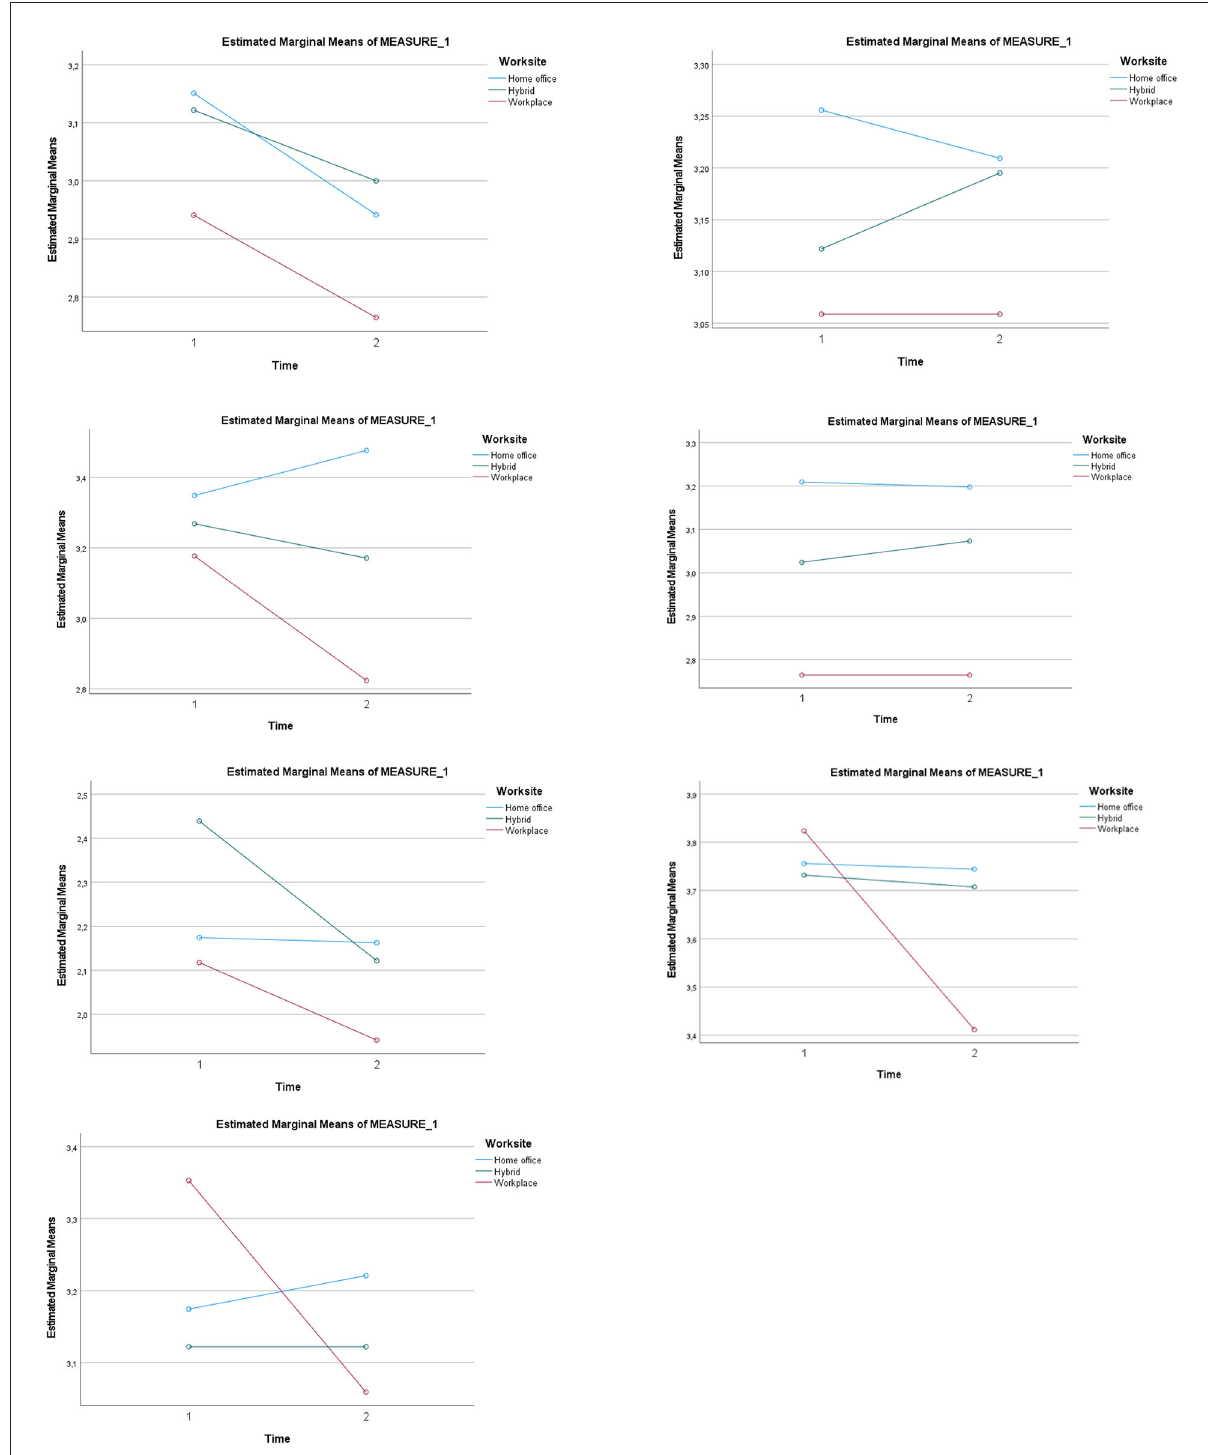
FIGURE1 Interaction effects for worksite and time from the seven separate repeated measures analyses of variance for all the evaluation of the job change